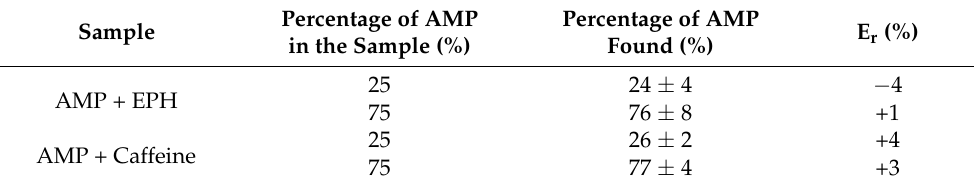
Table 2. Results obtained for binary mixtures with the proposed method ( n =